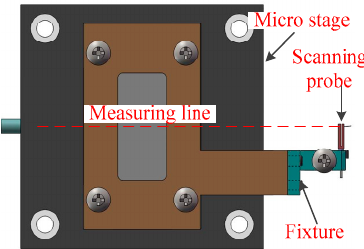
Figure 6. Assembly of the scanning probe and micro stage.